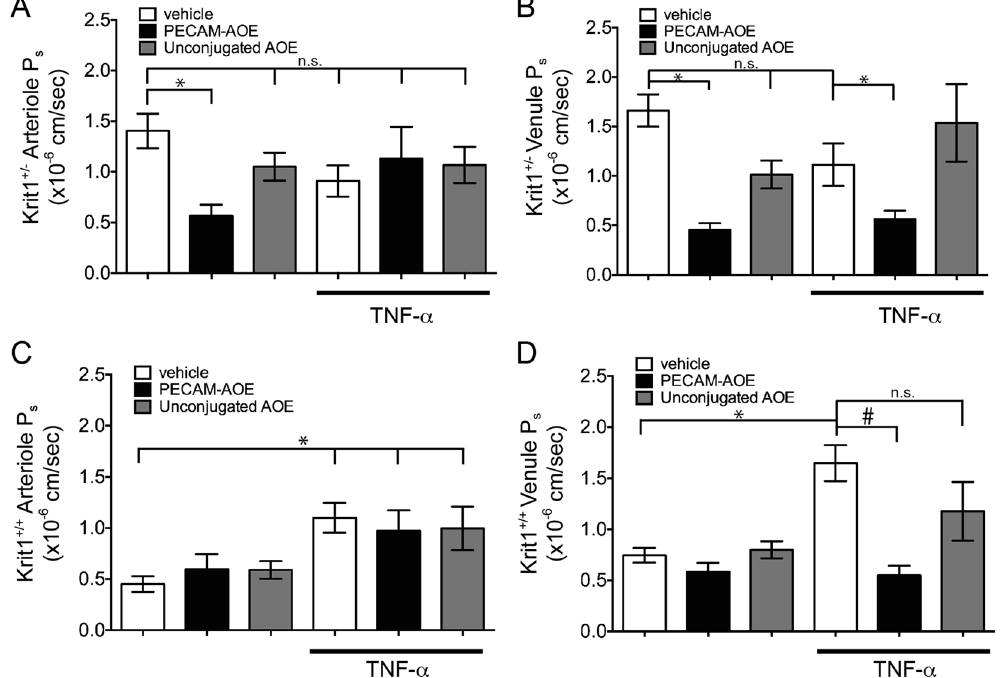
Figure 1. Endothelial-targeted antioxidant enzymes reverse increased micro-vessel permeability in KRIT1 deficient mice. ( A ) Cremaster arteriole permeability in KRIT1 heterozygous (Krit1 + / − ) mice treated with PECAM-AOE, unconjugated AOE, or vehicle alone + / − TNF- α . n = 10 vessel sites; p < 0.001 by non- parametric ANOVA; * p < 0.05 by Dunn’s post-hoc test, n.s.- not significant. ( B ) Cremaster venule permeability under same conditions as in ( A ). p < 0.001 by non-parametric ANOVA; * p < 0.05 by Dunn’s post-hoc test, n.s.- not significant. ( C ) Cremaster arteriole permeability in wild type (Krit1 + / + ) mice treated with PECAM- AOE, unconjugated AOE, or vehicle alone in the presence or absence of TNF- α . Data shown are the mean P s + / − SEM. n = 10 vessel sites; p < 0.001 by non-parametric ANOVA; * p < 0.05 by Dunn’s post-hoc testing. ( D ) Cremaster venule permeability under same conditions as in ( A ). p < 0.001 by non-parametric ANOVA; * p < 0.01 or # p < 0.05 by Dunn’s post-hoc test, n.s.- not